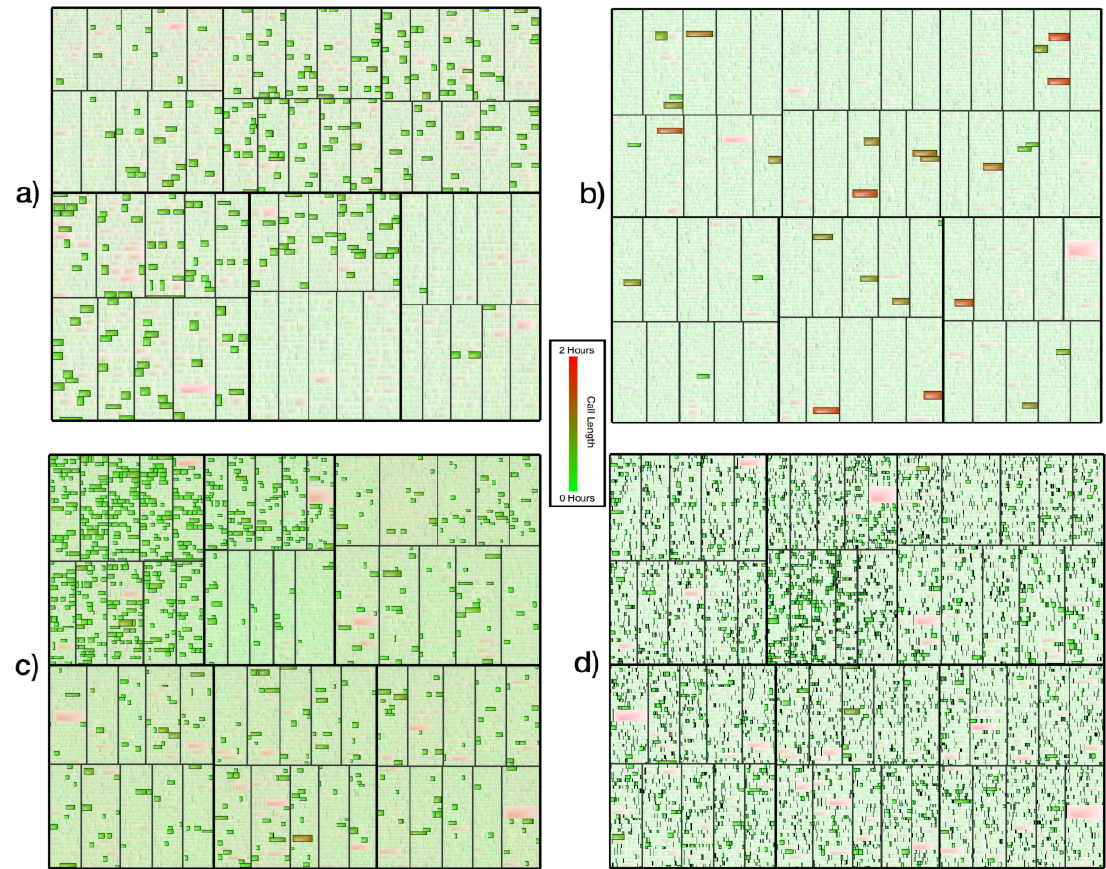
Figure 6. A focus + context treemap visualisation of call centre data: ( a ) all callers who have waited longer than 15 min in the queue but spoke to an agent for less than that period of time; ( b ) a combination of temporal and event based filters; ( c ) the increased queue time at the start of 13:00; and ( d ) all abandoned calls during the hour. Image courtesy of Roberts et al.